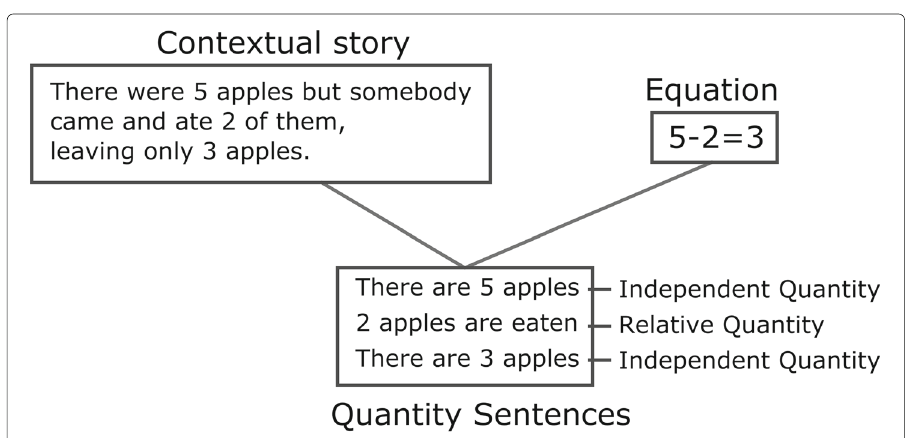
Fig. 1 The Triplet Structure Model. A diagram showing the composition of the Triplet Structure